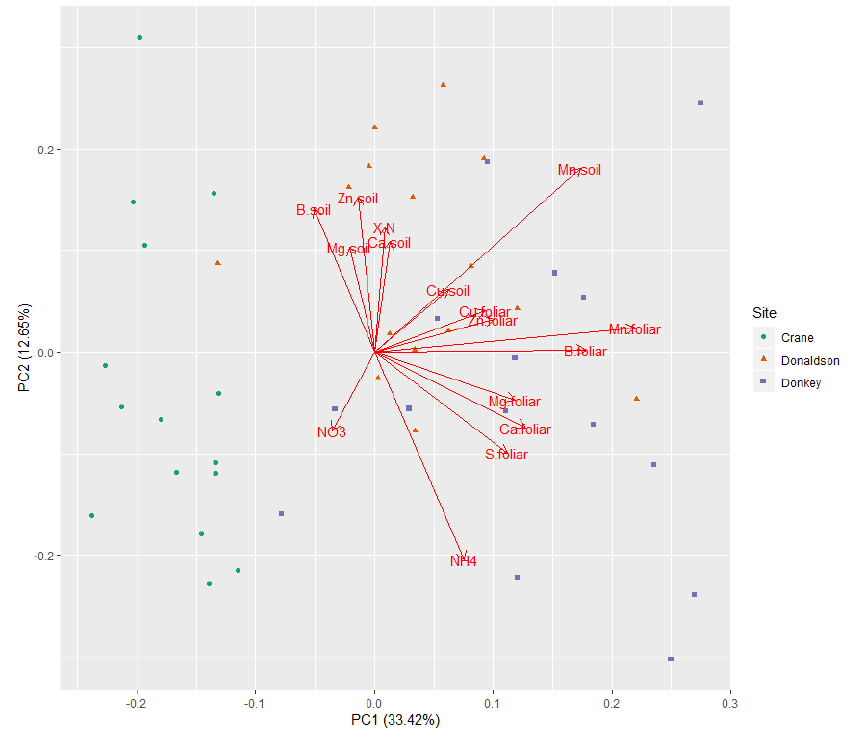
Figure 6. Principle components analysis for all nutrients across sites. For ease of interpretation, the first two axes are shown in this ordination .